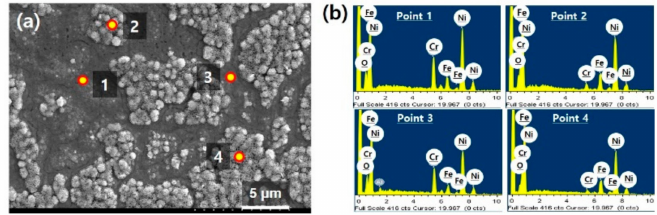
Figure 1. ( a ) SEM image of Inconel 600 substrate surface after air-annealing and plasma pretreatment; ( b ) results of EDS point analysis in ( a